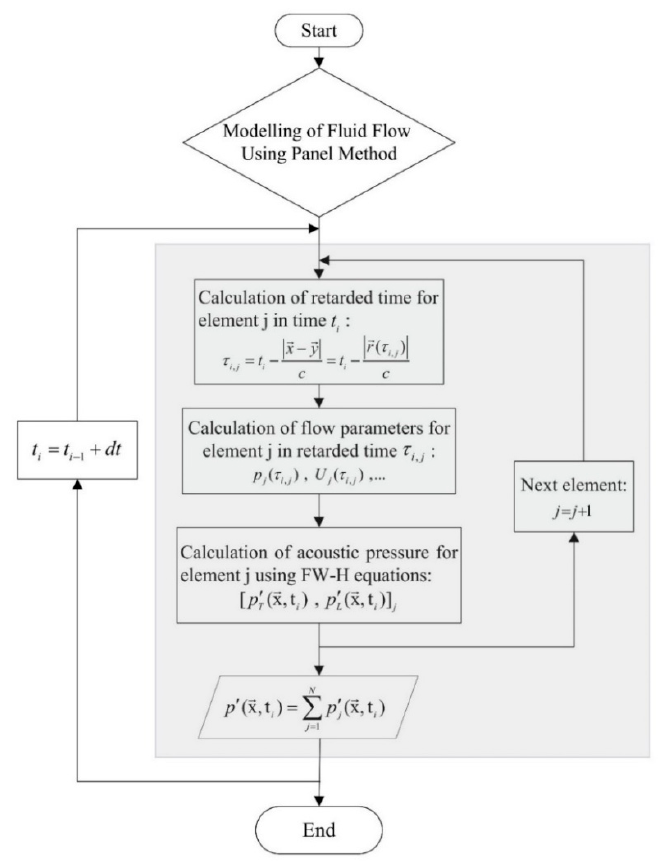
Figure 9. Flowchart of noise calculation using FW-H equations.